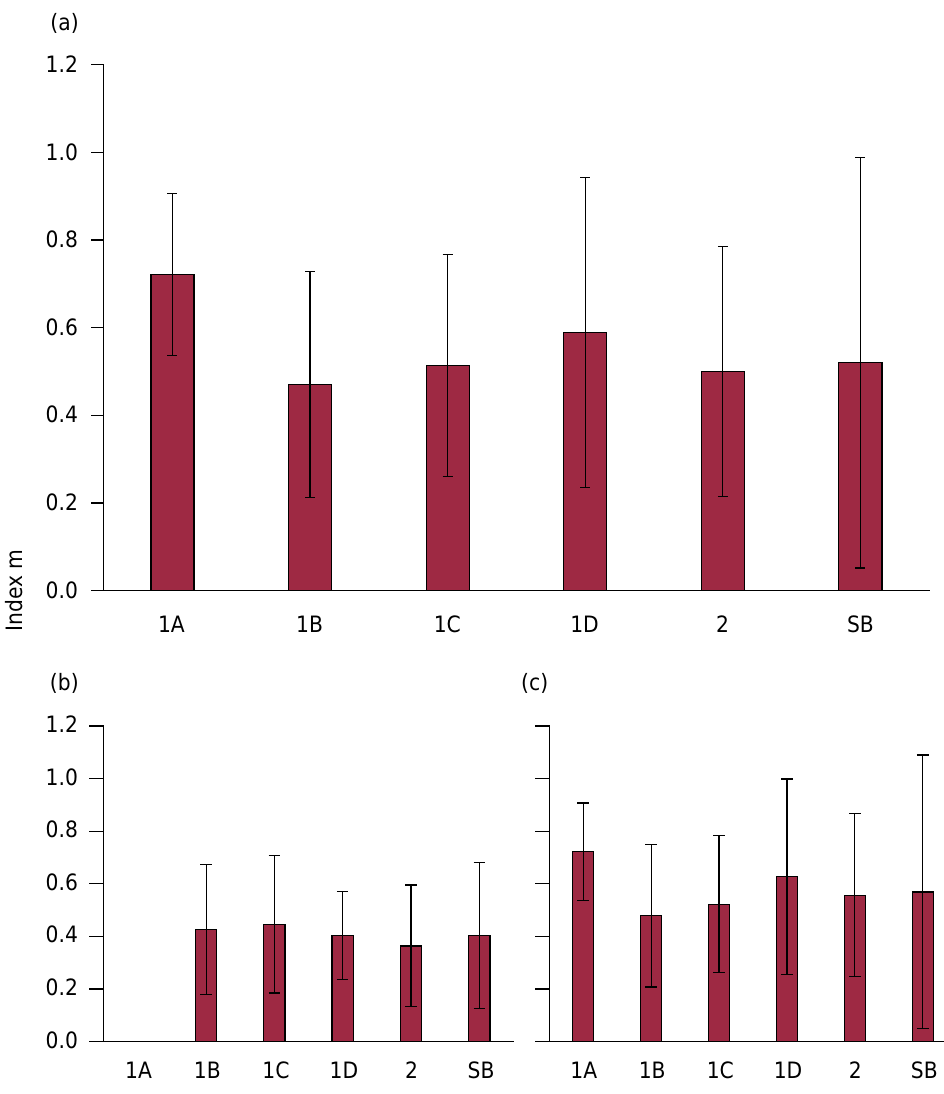
Figure 5. Index m calculated as the H-WoS index/scientific age ratio in years, in which the scientific age is equivalent to the number of years after doctorate thesis defense, for all researchers regardless of sex (a) and by gender women (b) and men (c), in CNPq Call 2018. Vertical bars depict standard